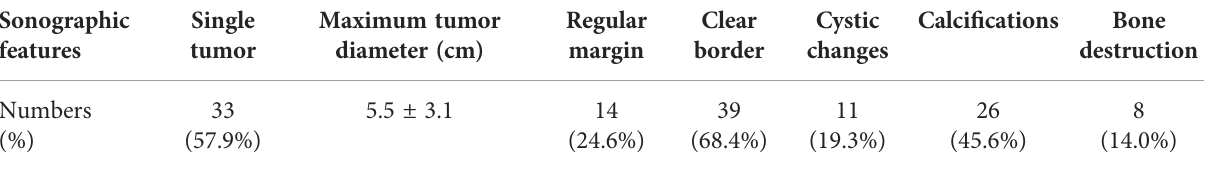
TABLE 2 Sonographic features of 57 tumor recurrence cases con fi rmed by pathology.